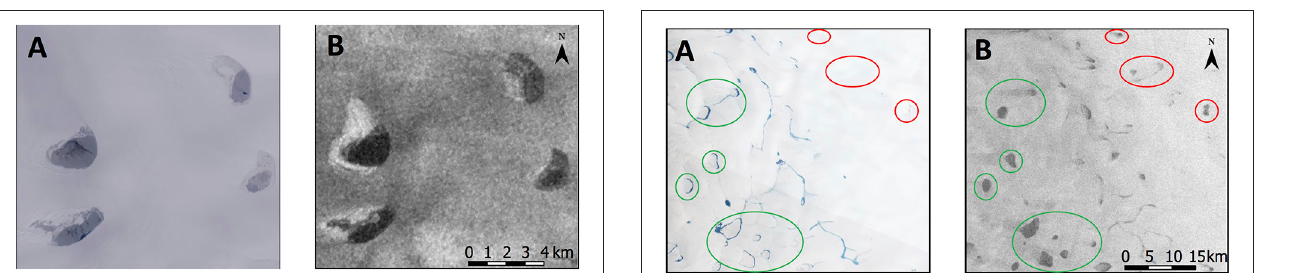
FIGURE 5 | Example of subsurface lakes in a Landsat false-color image ( A ; day 212, 2015) and a later Sentinel-1 image ( B ; acquired on day 239, 2015, HH polarization). A later Landsat scene was not available in this location due to cloud cover. The location within the study region is shown in Figure 1 . Green circles illustrate subsurface lakes that are partially visible in the Landsat image due to some peripheral melting; red circles demonstrate lakes that are never visible in the Landsat